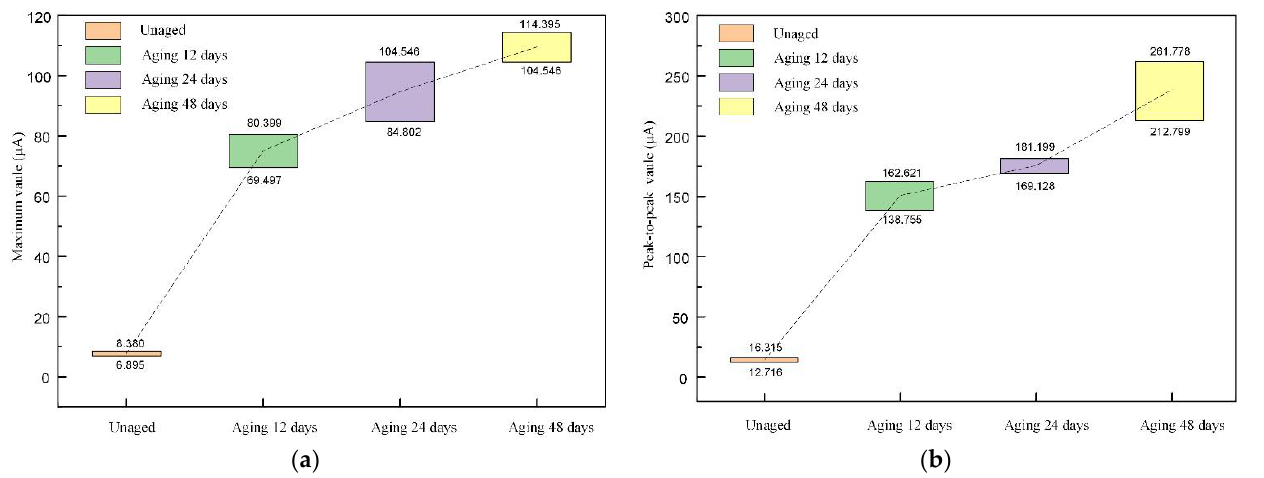
Figure 9. The distribution of dimensioned parameters in the time domain. ( a ) Maximum value; ( b ) peak-to-peak value.